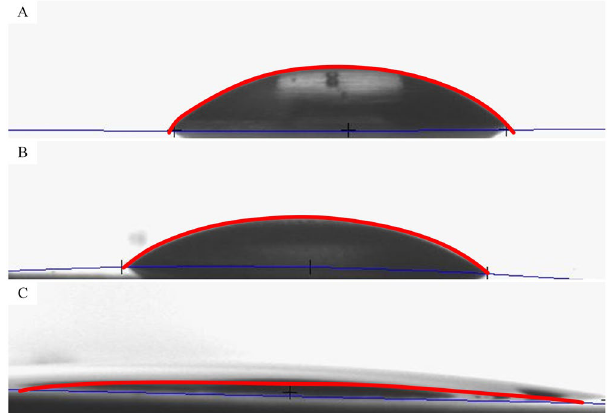
Figure 3. Contact angles on ( A ) Normal machine polished, ( B ) PO 15 and ( C ) PO 45 surfaces are measured to be 46.2 ± 1.5°, 38.6 ± 1.2° and 7.4 ± 0.2°, respectively.